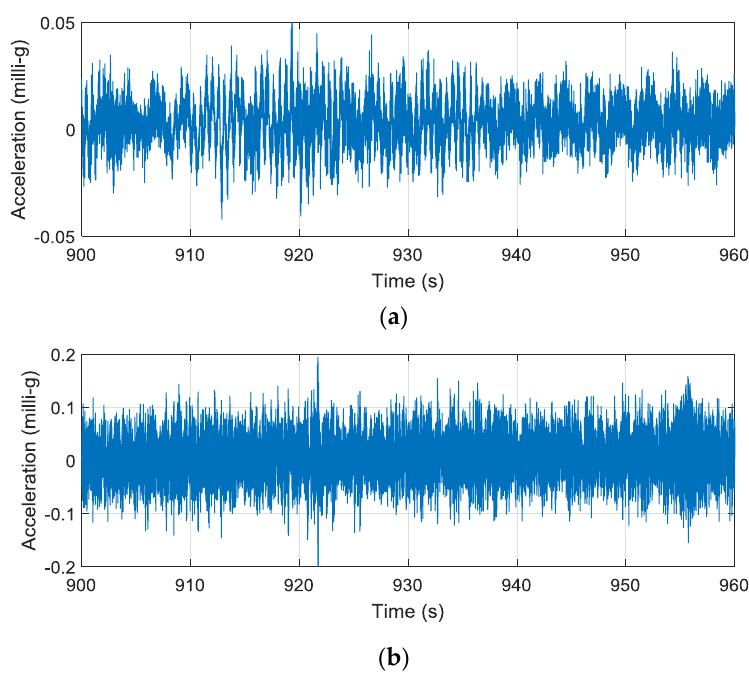
Figure 3. Measured acceleration time histories of Harbor View 1502: ( a ) x-direction and ( b ) y-direction.